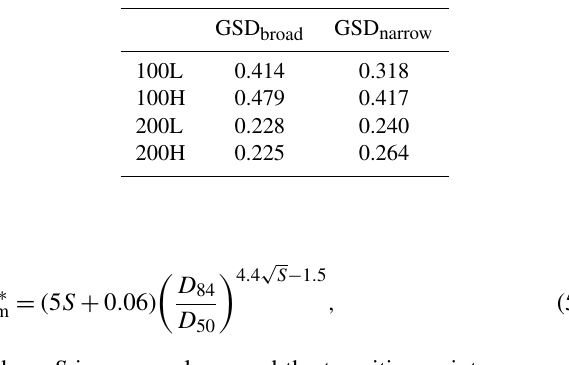
Table 8. Mixture mobility transition points calculated using Eq. (5), taken from Recking